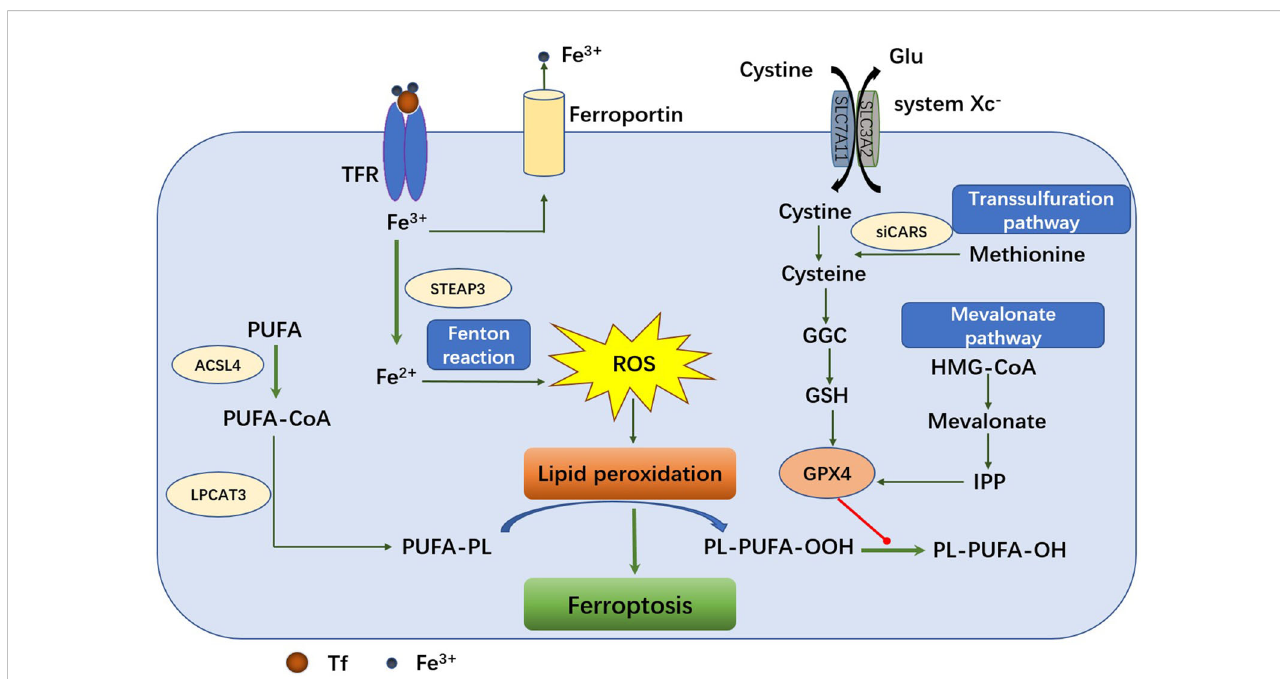
FIGURE 1 The mechanism of ferroptosis pathway. The main metabolic processes of ferroptosis can be roughly divided into three categories: iron metabolism, GSH/GPX4 pathway and lipid peroxidation. Transferrin transports the iron into cells by TFR1 ‐ mediated endocytosis. Fe 2+ promotes lipid peroxides accumulation through Fenton reaction and lipid oxidation. The system XC-retro delivers cystine to glutamate in a 1:1 ratio. Once inside the cell, cystine is oxidized to cysteine, which is used to synthesize glutathione (GSH) under the catalysis of glutamate-cysteine ligase (GCL) and glutathione synthase (GSS). GPX4 can reduce toxic lipid peroxides (PL-OOH) to nontoxic lipid alcohols (PL-OH) using glutathione as a reduction cofactor. Cells can also acquire cysteine by reversing the transsulfuration pathway. Another GSH/GPX4-related pathway is the mevalonate (MVA) pathway. 3-hydroxy-3-methylglutaryl- coenzyme A (HMG-CoA) can be converted to MVA in MVA pathway. Long-chain fatty acid-CoA ligase 4 (ACSL4) and lysophospholipid acyltransferase 5 (LPCAT3) promote the binding of polyunsaturated fatty acids (PUFAs) to phospholipids to form polyunsaturated fatty acid-containing phospholipids (PUFA-PLS) and then be oxidized to lipid peroxides by